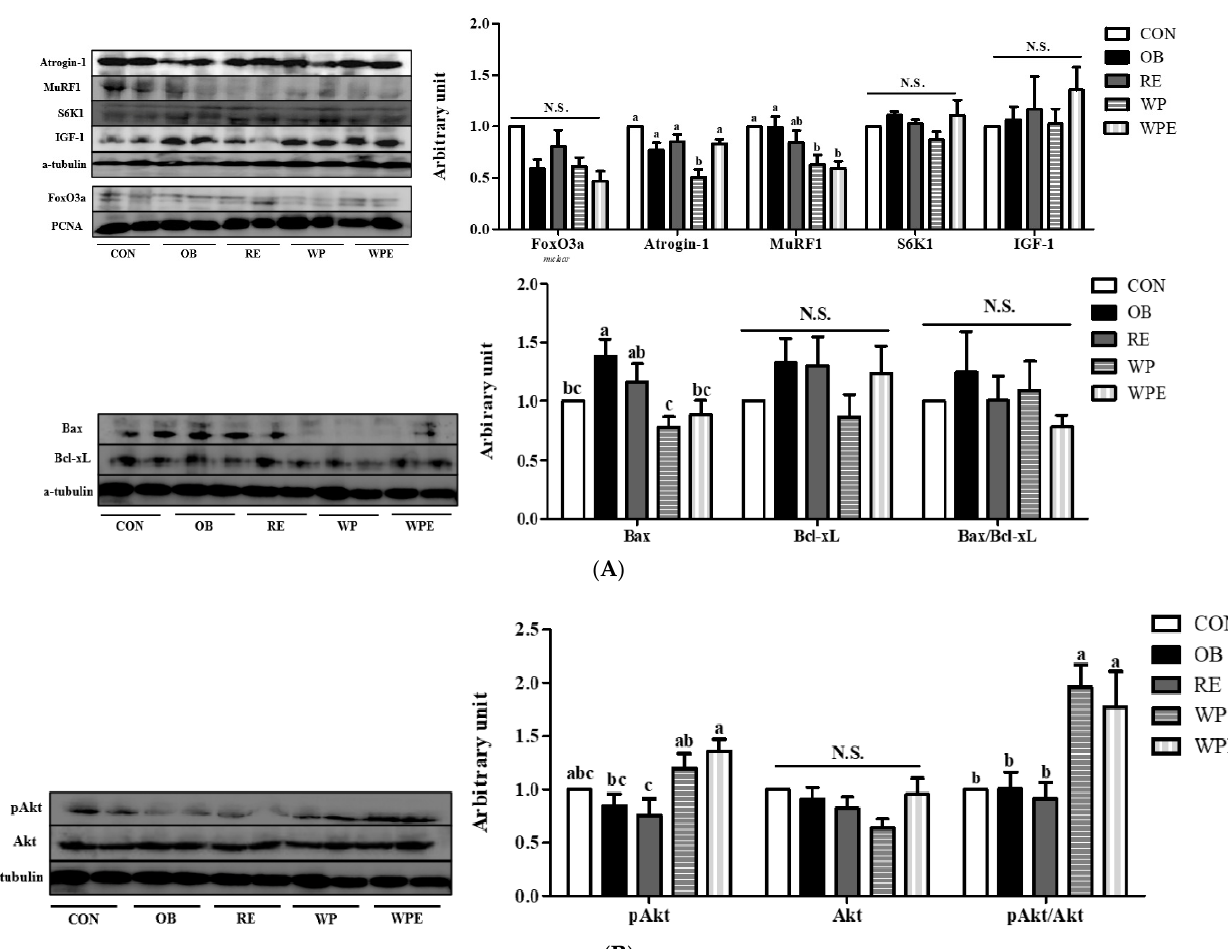
Figure 5. Effects of WP supplementation and RE on skeletal muscle protein and energy metabolism in sarcopenic obese mice. ( A ) Protein metabolism and ( B ) Energy metabolism. Values are means ± SEMs, n = 6–8. Mean values with the same superscript letter (a, b and c) are not significantly different ( p < 0.05). Bax, bcl-2-like protein 4; Bcl-xL, B-cell lymphoma–extra large; FoxO3a, forkhead box O3; Atrogin-1, muscle atrophy F-box gene; MuRF1, E3 ubiquitin–protein ligase; S6K1, ribosomal protein S6 kinase beta-1: IGF-1, insulin-like growth factor I; Akt, protein kinase B. N.S.—Not